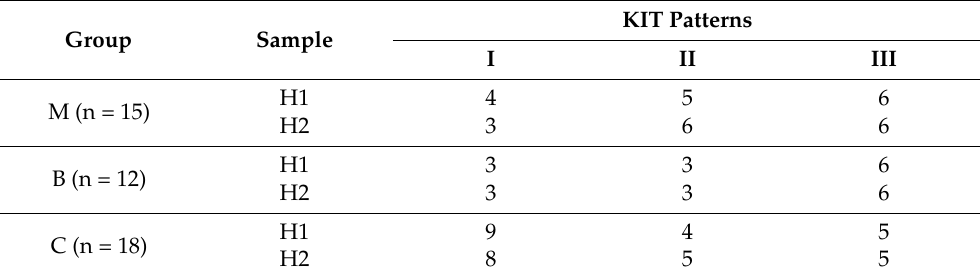
Table 4. Characterization based on KIT distribution allocated in samples H1 and H2.